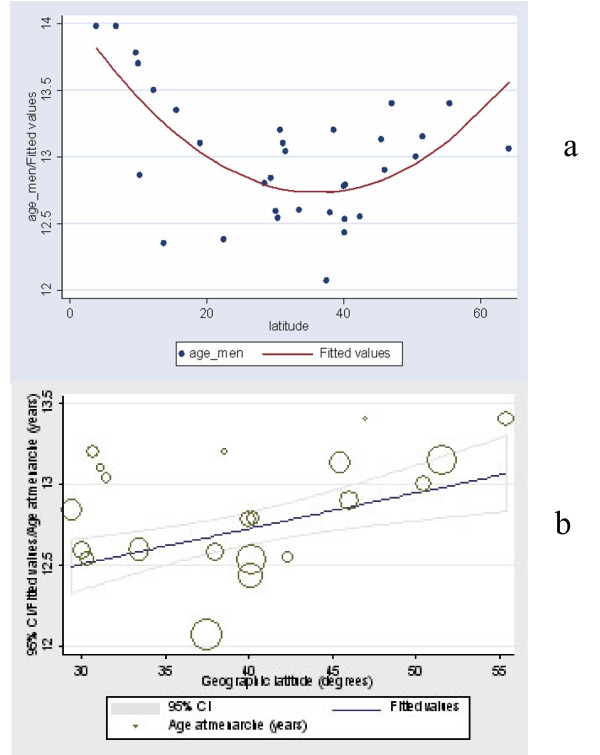
A. Illustration of the regression of age at menarche (in years) by latitude   (in degrees) (p < 0.001). B. The linear correlation between age at menarche   and geographic latitude is better shown in the figure where all observations   below latitude of 25 degrees are not described.